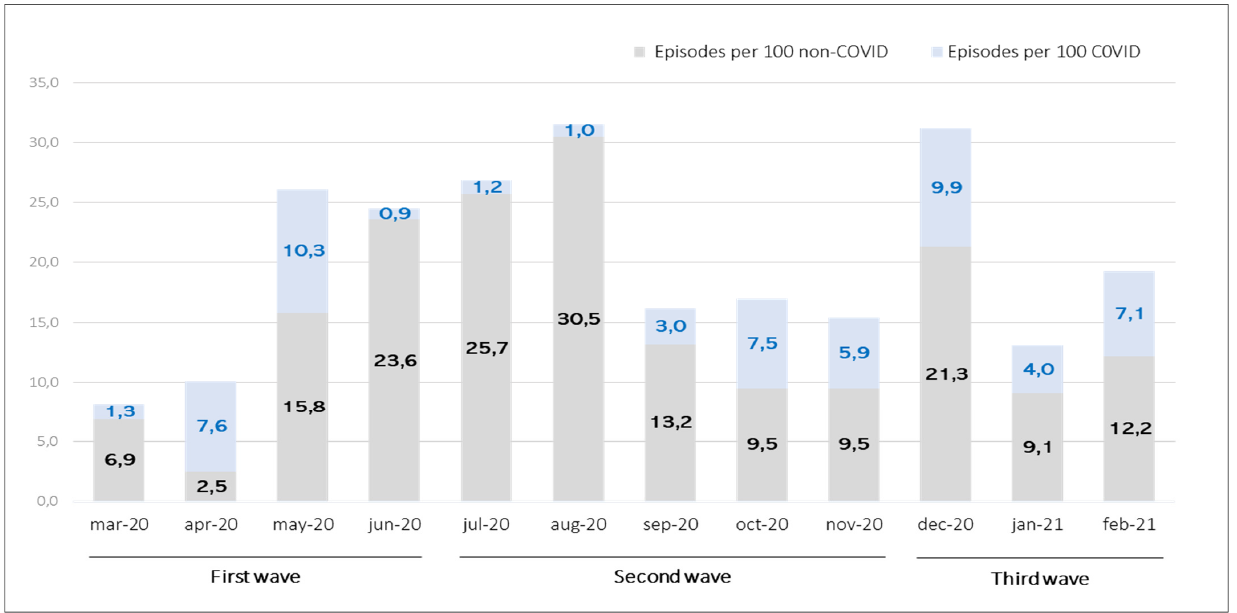
Figure 3. Monthly comparison of skin wound episodes (per 100) in COVID-19 versus non-COVID-19 patients during first year of the COVID-19 pandemic.